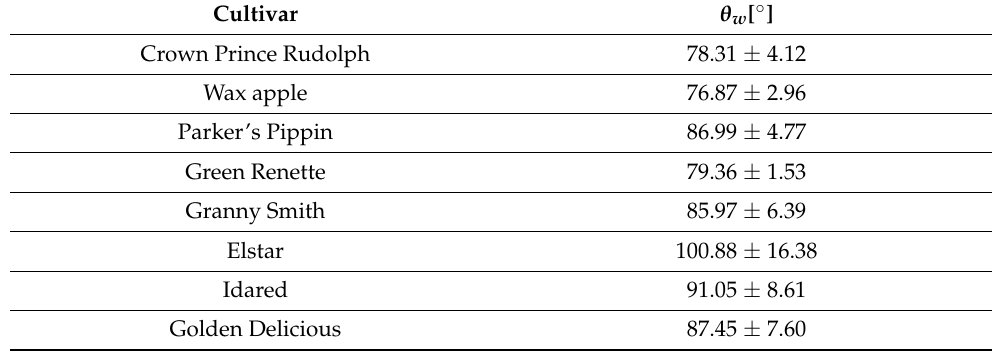
Table 2. Contact angles θ w of all cultivars used (measured on the equatorial region). The volume of the water droplet varied between 4.1 µL and 6.3 µL.